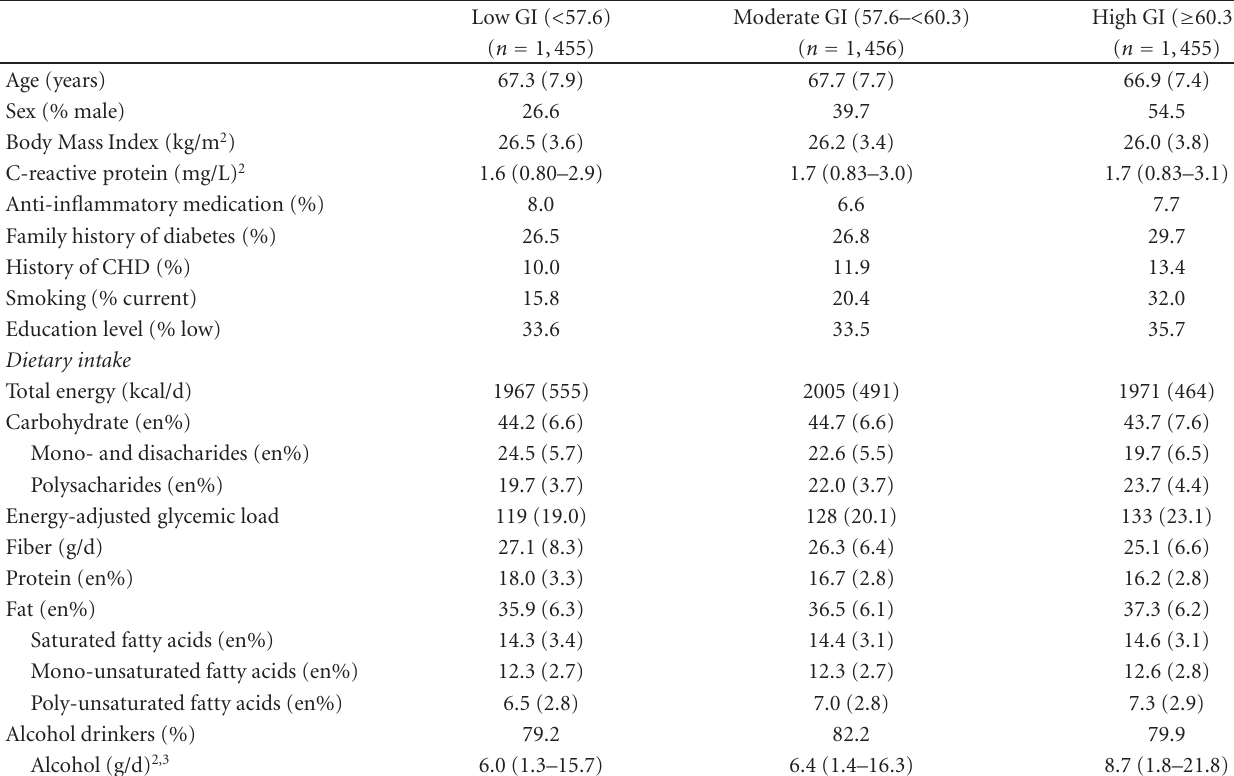
Table 1: Baseline characteristics of 4,366 Dutch adults aged ≥ 55 years by tertiles of energy-adjusted glycemic index (GI).